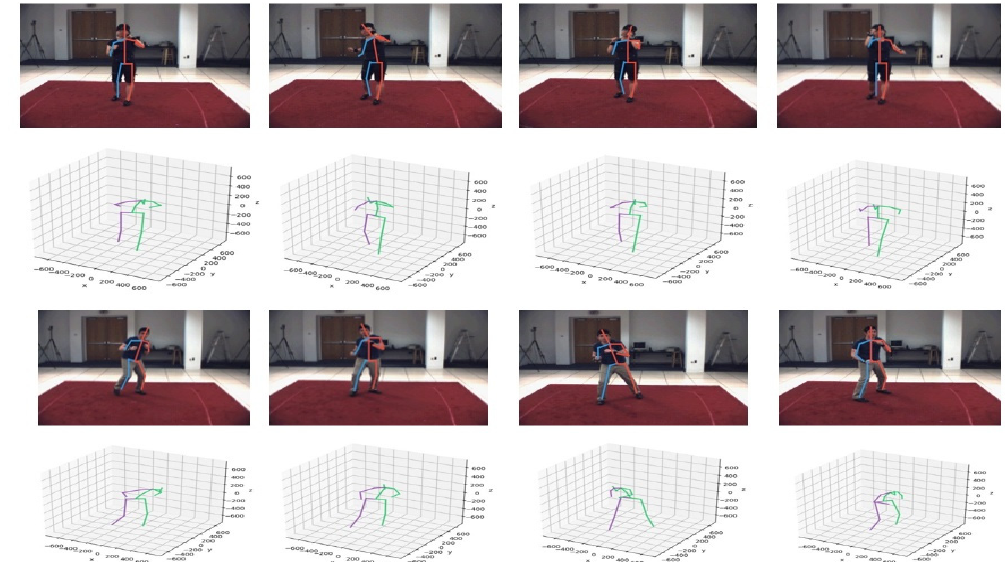
Figure 5. Example of skeleton joints extraction from RGB images sequence by temporal video 3D human pose estimation-Pose_3D.